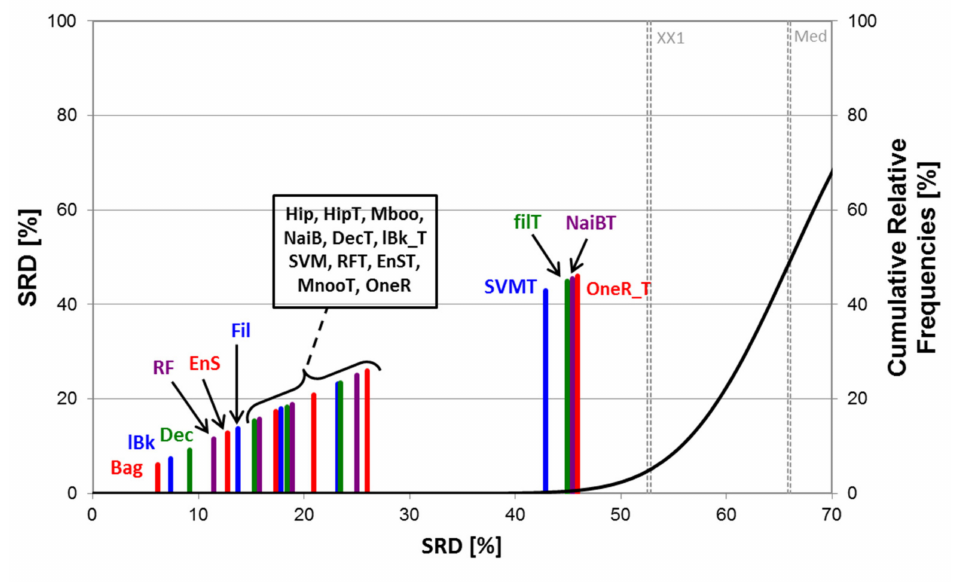
Figure 7. SRD analysis (for the Daphnia Magna dataset in the multiclass case, with imbalanced classes). Normalized SRD values are plotted on the X and left Y axes. The abbreviations of the classifiers can be found in Section 3.2. The cumulative relative frequencies (black curve, right Y axis) correspond to the randomization test. The “T” su ffi x indicates external test validated predictions, the lack thereof indicates cross-validated